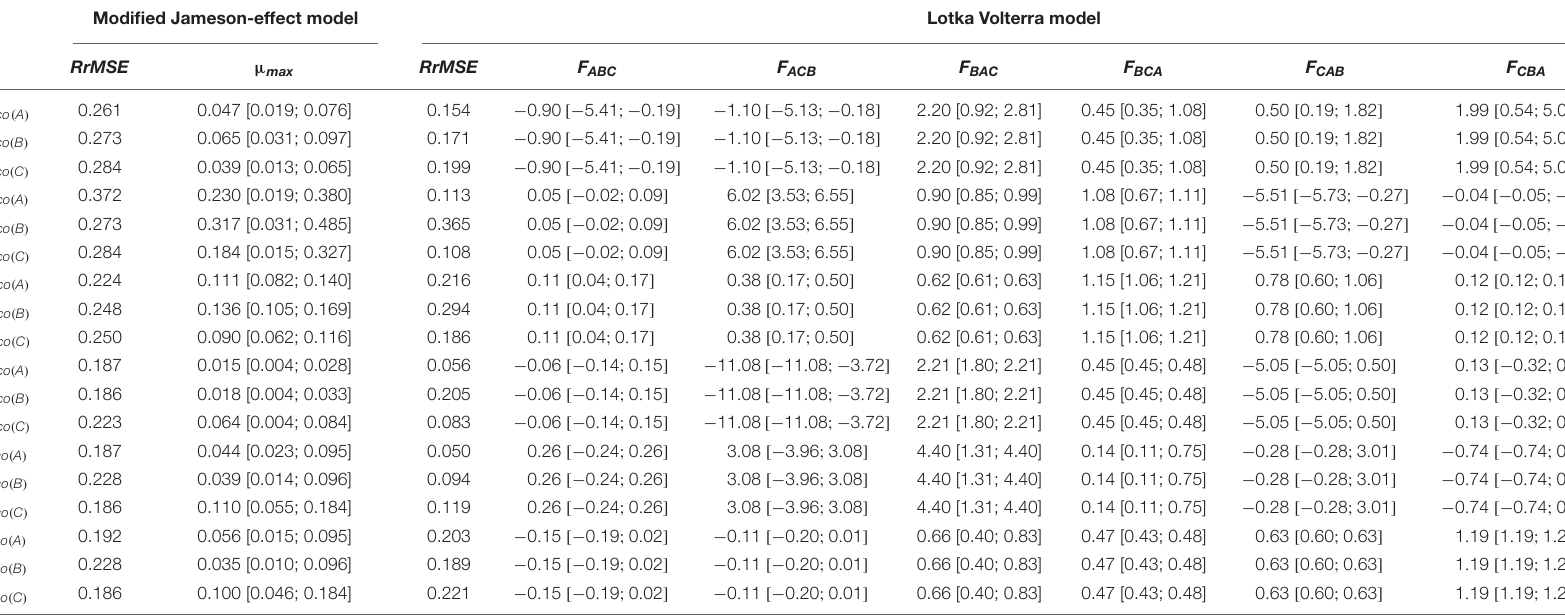
See Table 1 for the list of codes used. Mean values with the 95% confidence intervals (lower limit and upper limit). RrMSE, the root-mean-square error of the residuals; µ max , the maximum growth rate (1/h); F ABC , F ACB , F BAC , F BCA , F CAB , F CBA , the coefficient of interaction measuring the effects of one species on the others ( A , B. thermosphacta; B , Pseudomonas spp.; C , L. gelidum;